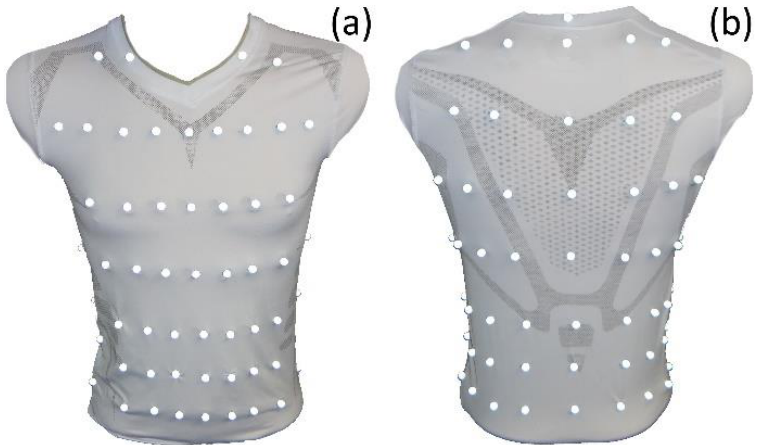
Figure 2. Compression shirt with 102 reflective MoCap markers — ventral view ( a ) and dorsal view (right). The reference point in dorsal view ( b ) is the uppermost MoCap marker on the collar of the shirt.